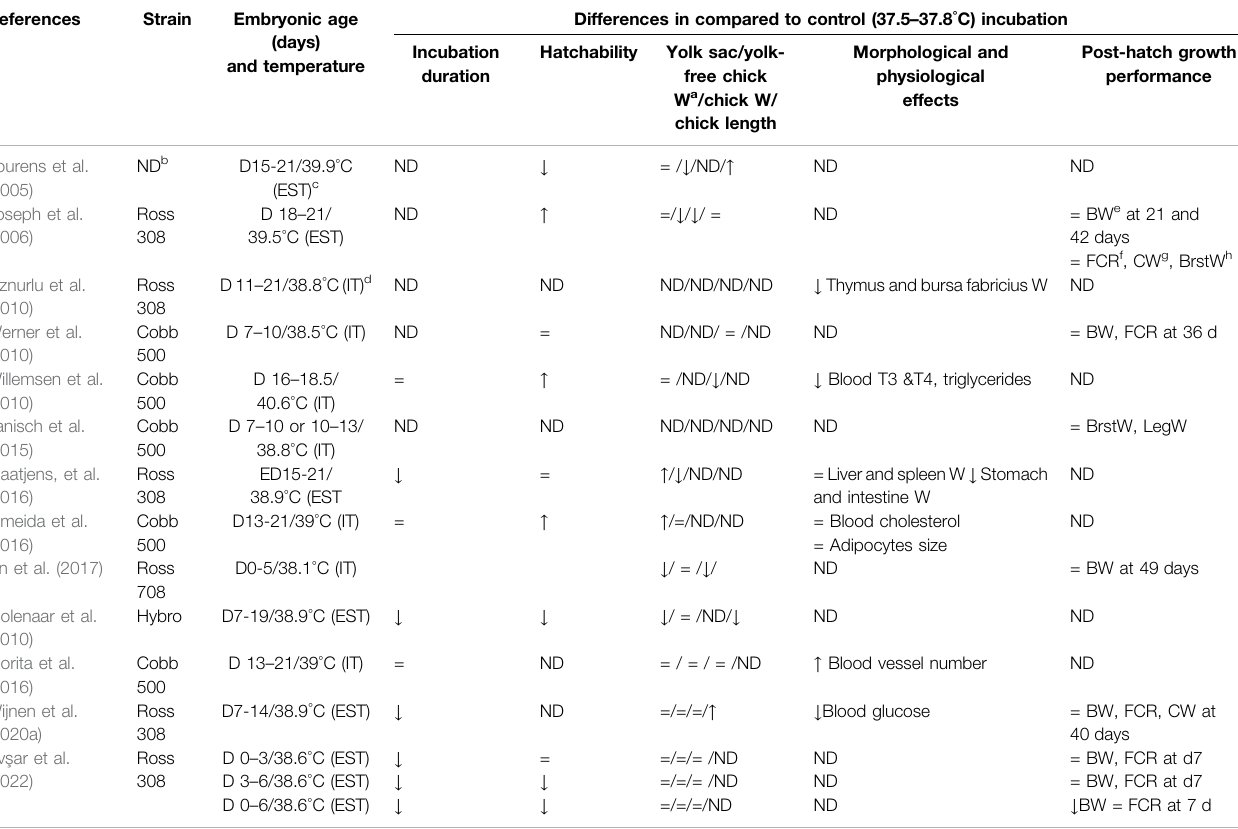
TABLE 1 | Higher than optimum incubation temperature: Effects on the embryo ’ s physiology and post-hatch